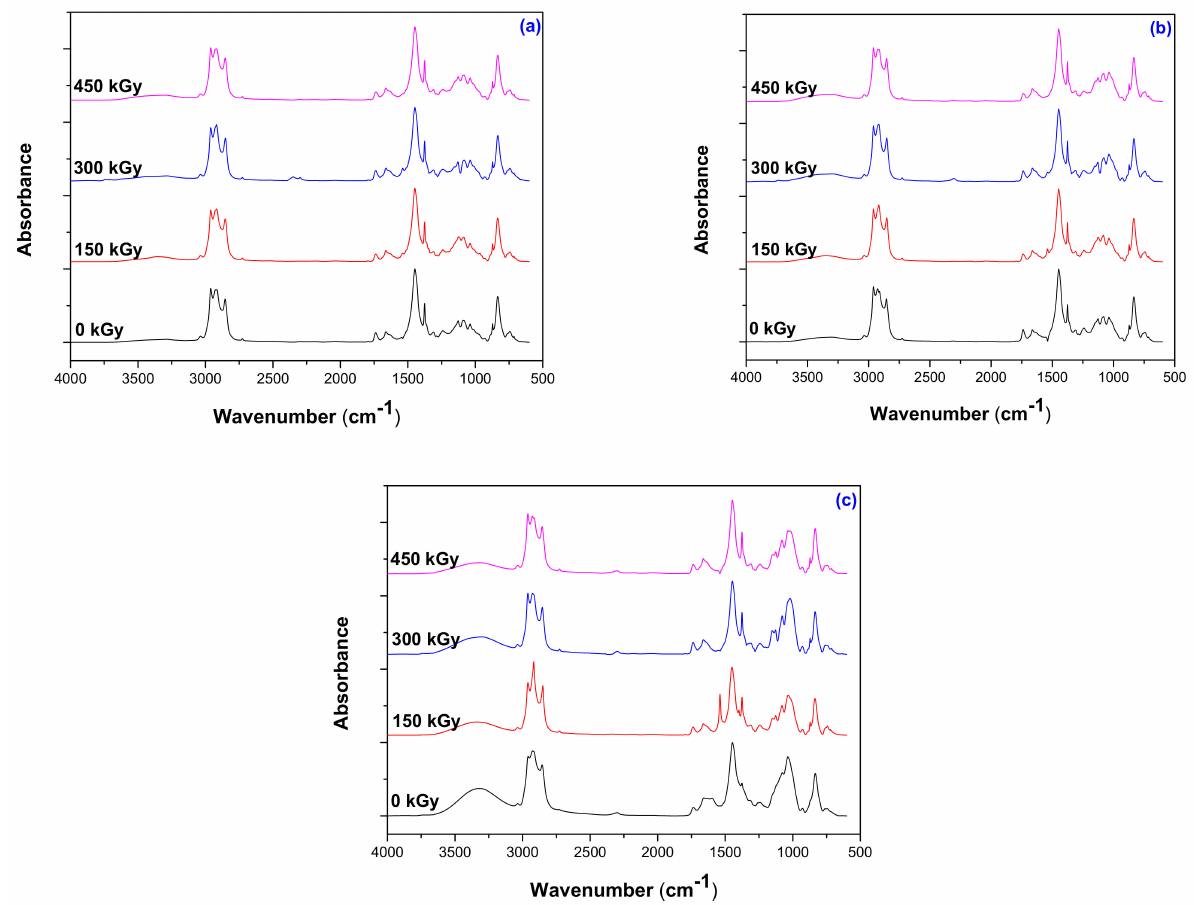
Figure 9. FTIR spectra for NR/PS composites ( a ) without PS (C0); ( b ) with 10 ppm of PS (C10); ( c ) with 50 ppm of PS (C50) in the range of 4000–600 cm − 1